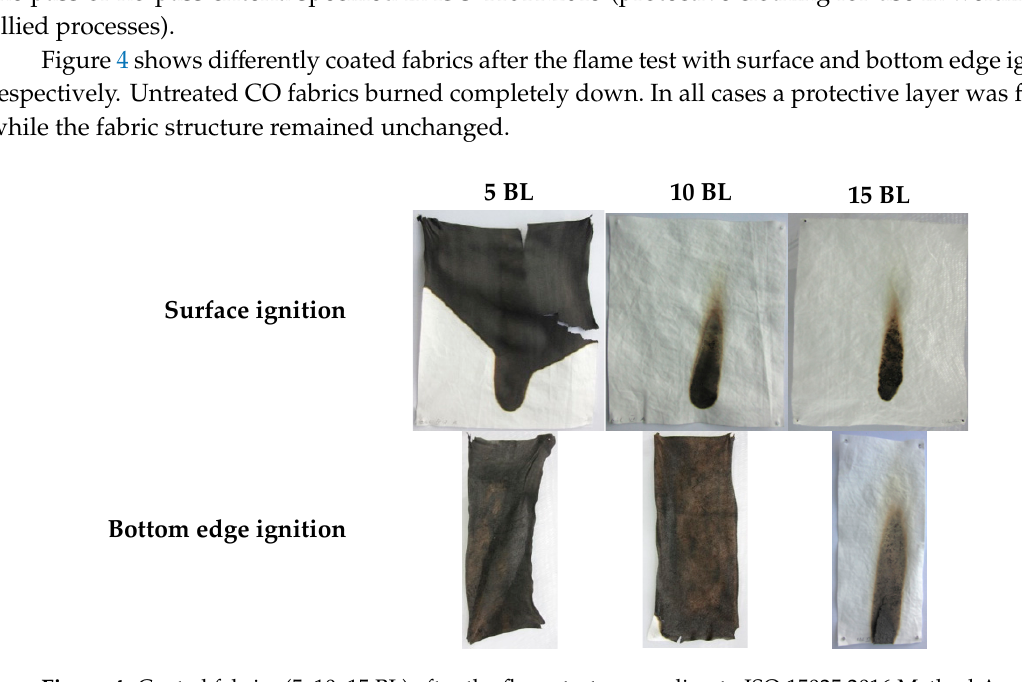
Table 5. Flame test results of coated cotton samples according to ISO 15025:2016. The stated rating— pass, no pass—is based on two criteria specified in ISO